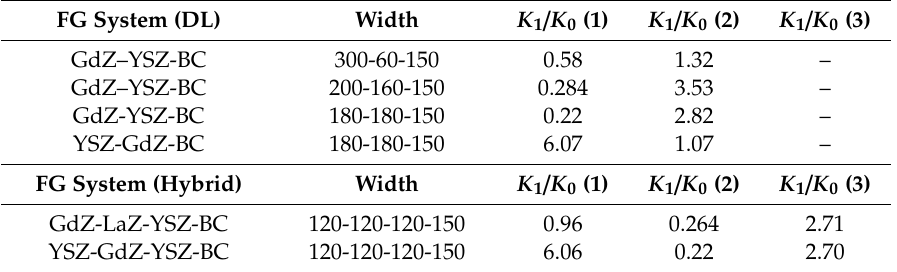
Table 3. Normalized SIF K 1 / K 0 for di ff erent Double Layer (DL) and Hybrid TBC